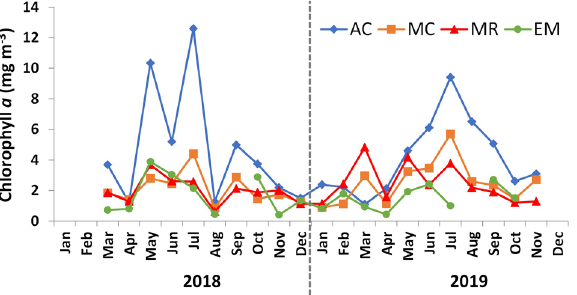
Figure 5. Chlorophyll a concentration (mg m −3 ) obtained in the Sado Estuary during sampling: AC—Alcácer channel, MC—Marateca channel, MR—middle region, EM—estuary mouth. No data available at EM for September 2018 and August